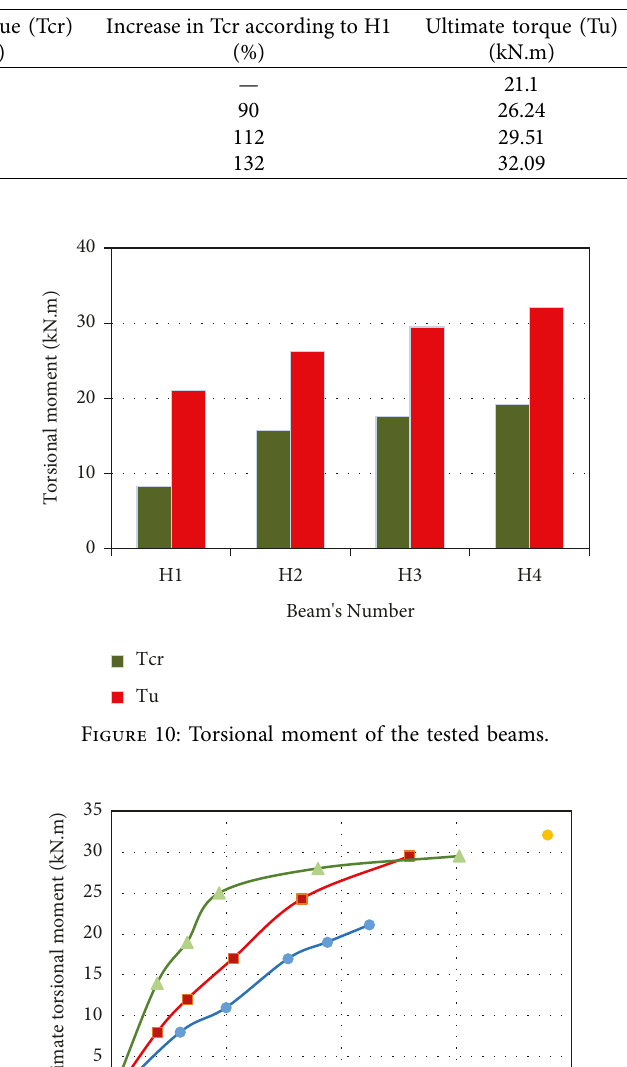
Table 9: Effect of steel fiber ratio on cracking and ultimate torsional moment.